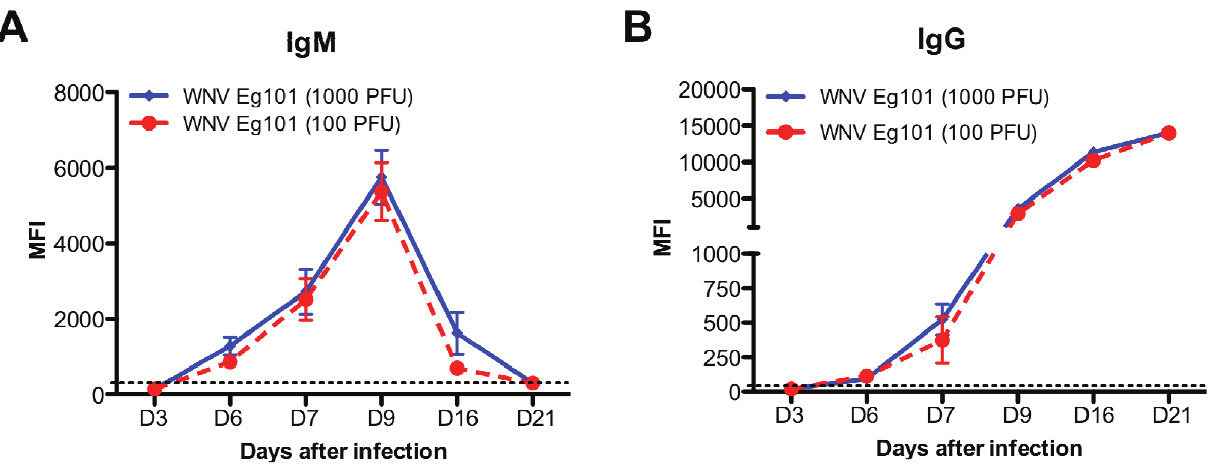
Figure 3. WNV-specific IgM and IgG antibodies titers in the serum of WNV Eg101 infected mice. Serum was collected from WNV Eg101 infected mice at indicated time points and WNV-specific ( A ) IgM and ( B ) IgG responses were measured by MIA using WNV E antigen as described in materials and methods. Results are reported as median fluorescent intensity (MFI) per 100 microspheres. Data are expressed as MFI ±SEM and is representative of two independent experiments (n = 8–16 mice per group). Dotted line indicates the cutoff value.